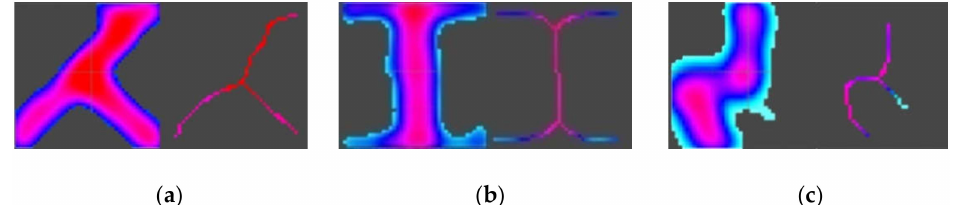
Figure 8. Extract road centerlines by thinning an image slice; ( a ) from a skewed T-shaped intersection. ( b ) from a road segment; and ( c ) result with a spurious road due to GPS